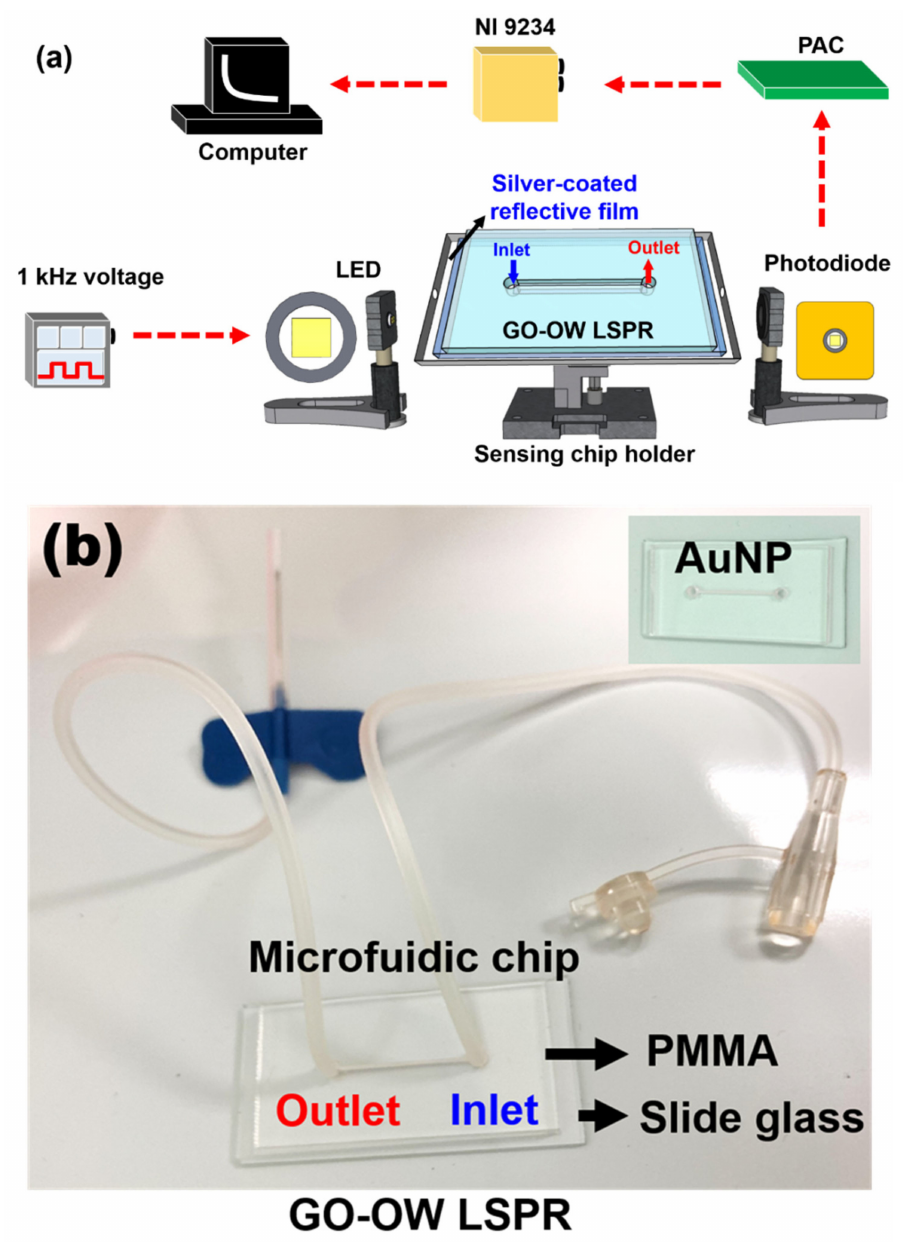
Figure 2. GO-OW LSPR sensor. ( a ) Schematic representation of the experimental setup of the sensing system, and ( b ) sensing